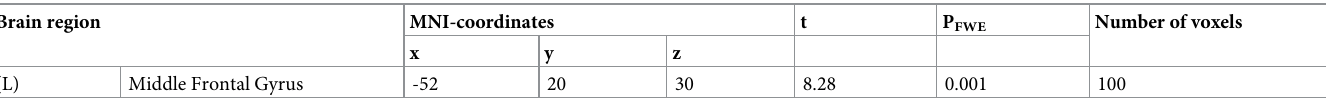
Table 4. Activation peaks for refinement (B2) versus copy drawing